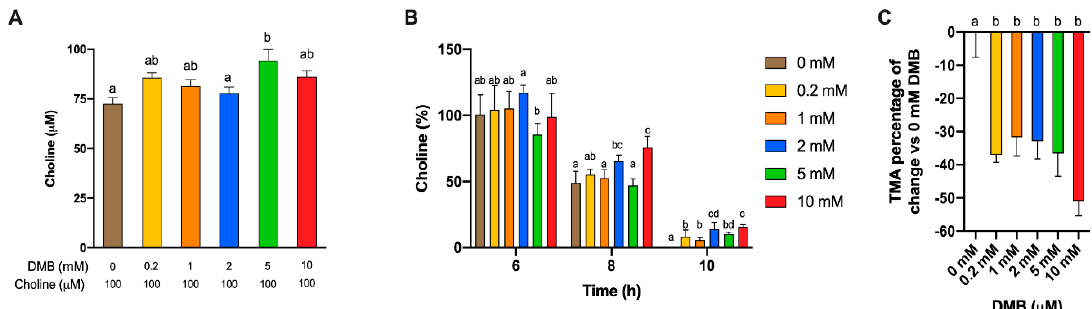
Figure 5. Initial choline concentrations at fermentation with fecal slurry 20%, choline 100 µM and DMB concentrations of 0–10 mM ( A ). Relative changes in choline at 6, 8 and 10 h against initial choline concentrations ( B ). Relative changes in TMA concentration at 12 h against DMB 0 mM ( C ). Results are expressed as mean (µM or%) ± SEM ( n = 6). Different letters indicate statistical differences ( p < 0.05) by one-way ANOVA (Tukey’s post hoc test) within each time point.